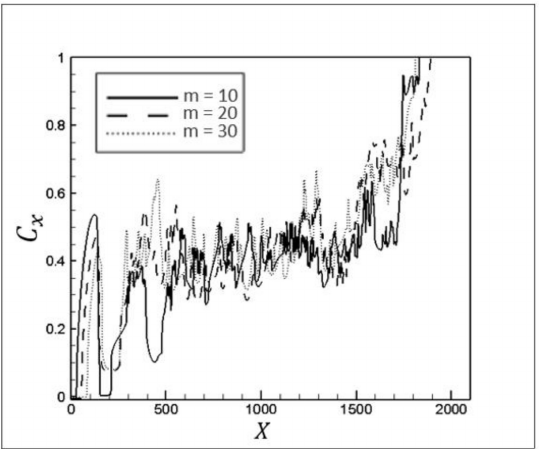
Figure 29. Transverse displacement efficiency over the channel length for different